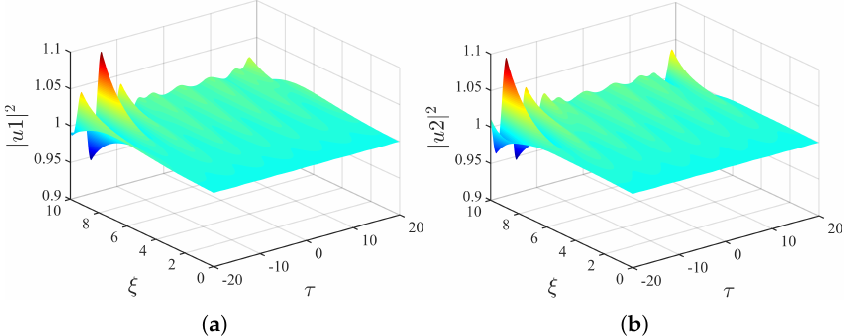
Figure 15. The influence of the group-velocity mismatch, ρ = 1, on the evolutions of the MI in the bar ( a ) and cross ( b ) channels in the anomalous-GVD regime. Other system parameters are,